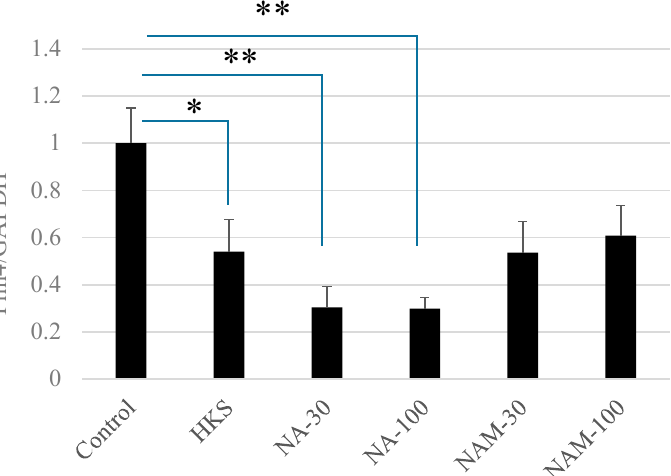
Figure 2. Bifidobacterium breve MCC1274 extracts and niacin reduce PLIN4 mRNA expression in SH-SY5Y neuroblastoma cells. The SH-SY5Y cells were exposed to HKS ( B. breve MCC1274 heat-killed cell extracts, 1% final v/v), niacin (NA), or niacinamide (NAM) (final concentration of 30 or 100 nM) for 1 h. Human PLIN4 mRNA expression relative to human GAPDH was determined by RT-PCR. The data are shown as the mean + SD of three replicates. * p < 0.05, ** p < 0.01 (non-repeated measures ANOVA with the Bonferroni post hoc test).